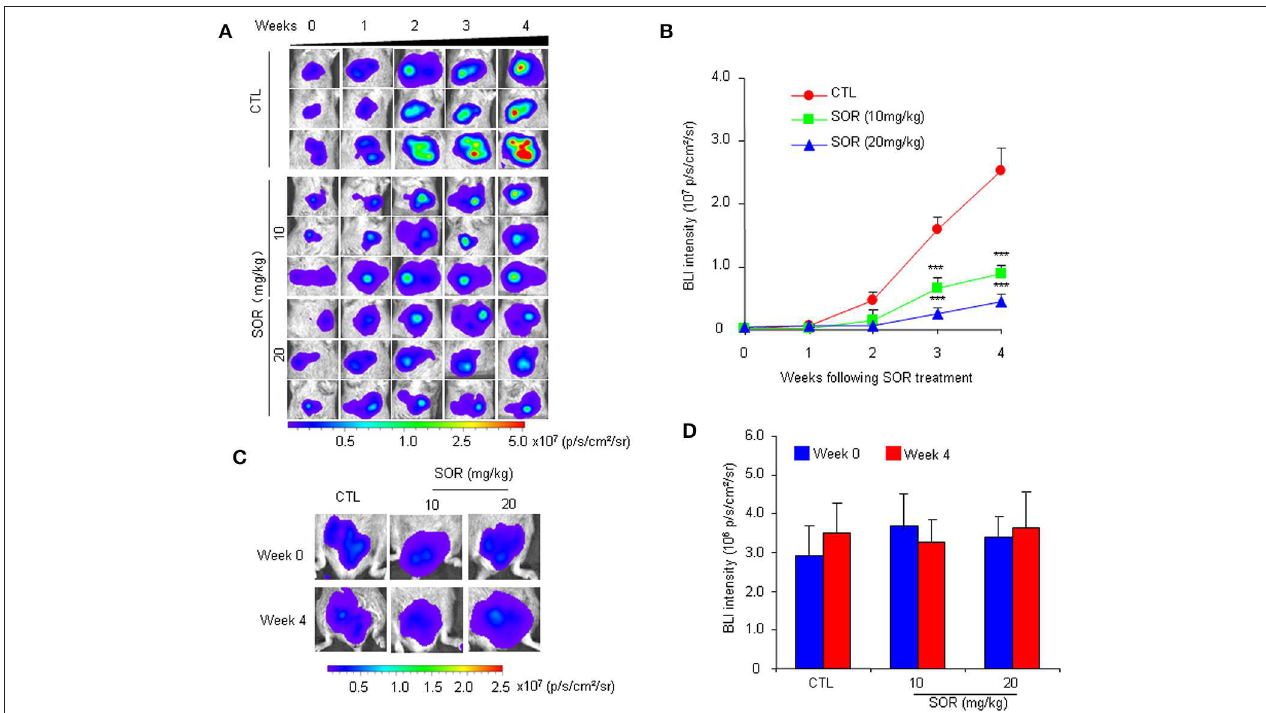
FIGURE 2 | Non-invasive monitoring of BLI signals in the liver and testes area of HCR mice following sorafenib treatment.AQQ17 (A) Serial in vivo bioluminescence imaging of livers in representative mice treated with an oral dose of 10 or 20 mg/kg sorafenib (SOR) or vehicle control solution (CTL) for 4 weeks. (B) Quantified liver bioluminescence intensity in mouse groups that underwent vehicle or sorafenib treatment ( n = 8). (C) The representative bioluminescence imaging of the testes area from mice treated with sorafenib (SOR) or vehicle solution (CTL). (D) Quantified bioluminescence intensity of the testes area from mice that underwent vehicle or sorafenib treatment for 4 weeks ( n = 8). *** P < 0.001 vs.